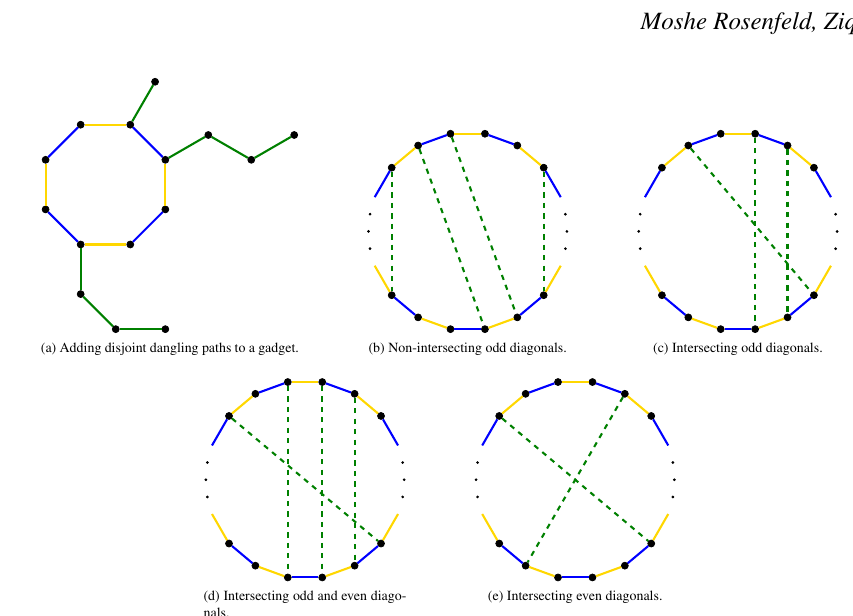
Fig. 5: Dashed lines are disjoint